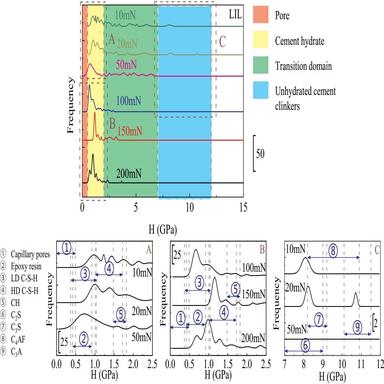
Hardness distributions of the HCP from the LIL scratches with different maximum loads, where these in the range of 0–2.5 GPa with the low (10, 20 and 50 mN) and high loading levels (100, 150 and 200 mN) are plotted in subpanels A and B, respectively; and these in the range of 7–12 GPa with the low loading levels (10, 20 and 50 mN) are plotted in subpanel C.